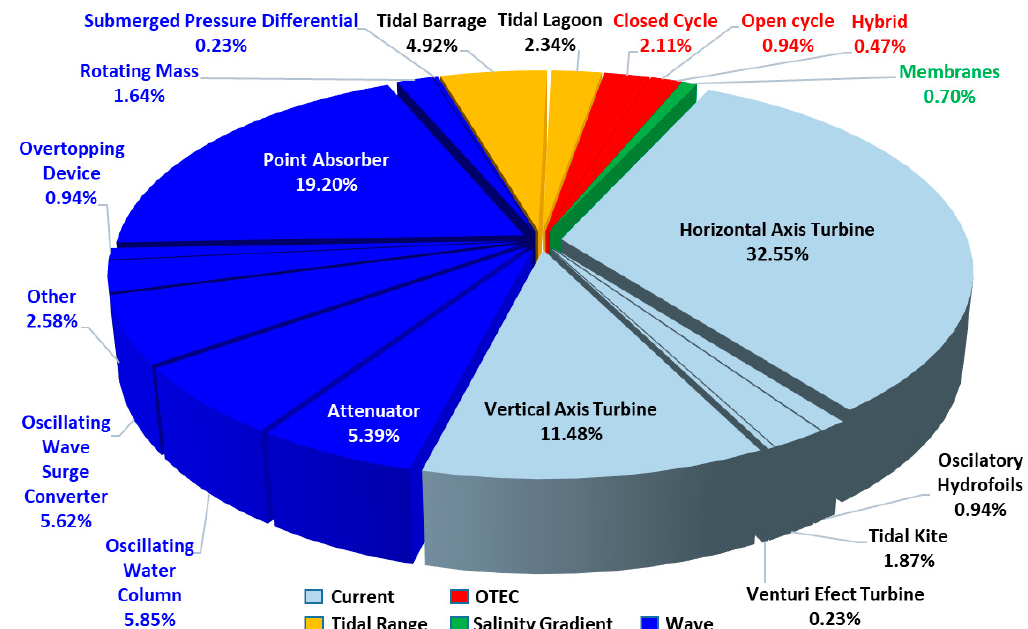
Figure 12. Technology distribution among projects.